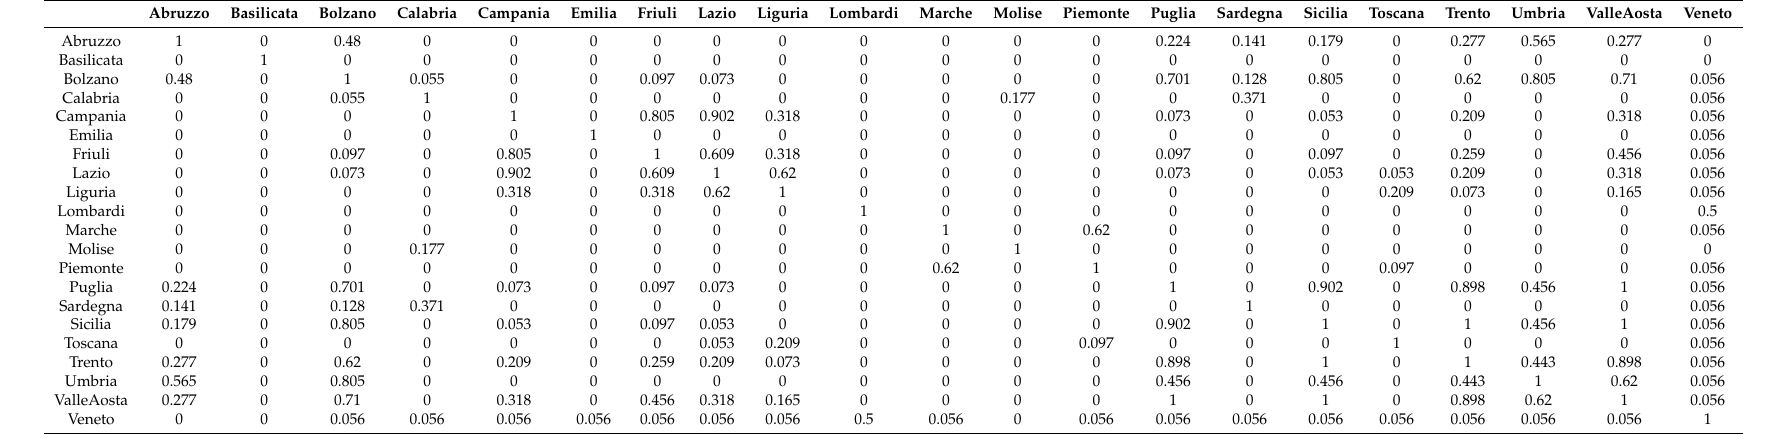
Table A52. Similarity values of Total Cases network in the third